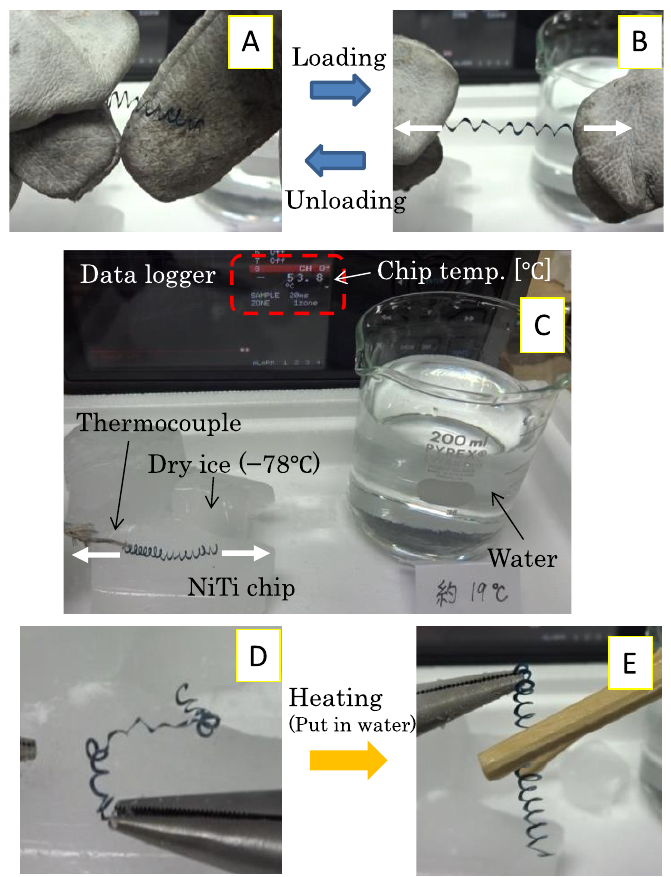
Figure 15. Experiment to evaluate the shape memory effect of the chip. ( A ) original chip shape or unloading the thensile load ( B ) applying the tensile load at room temperature ( C ) cooling the chip on dry ice ( D ) applying the tensile load after cooling the chip ( E ) dipping the chip of D in water.